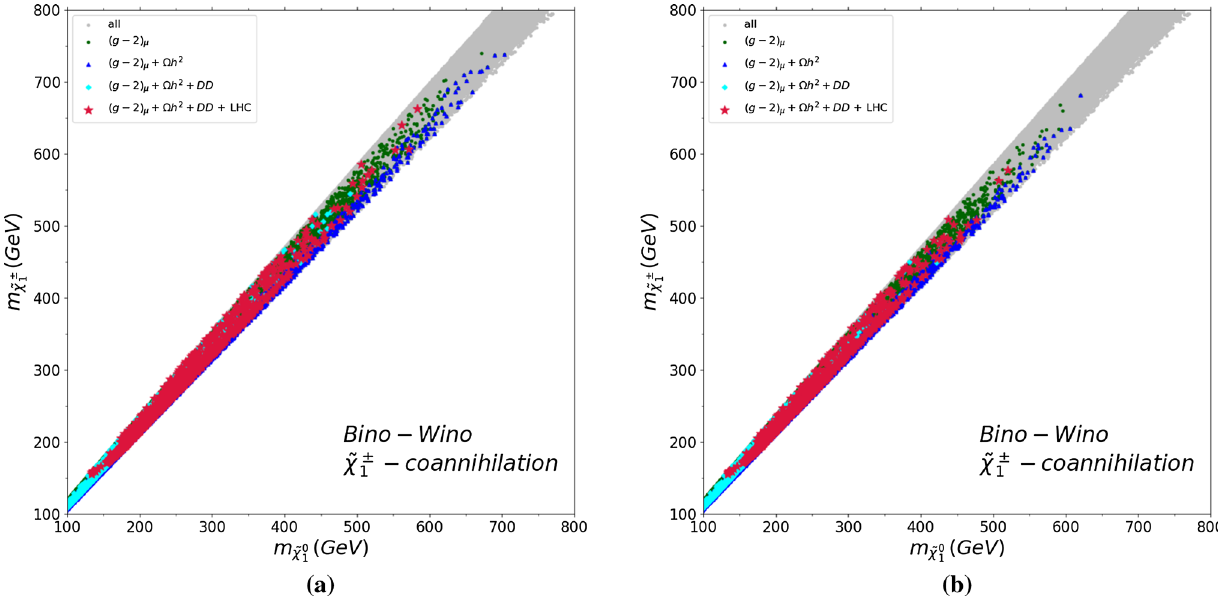
− m plane for the bino-wino ˜ χ ± -coannihilation scenario for current (left) and anticipated ˜ χ ± 1 1 1